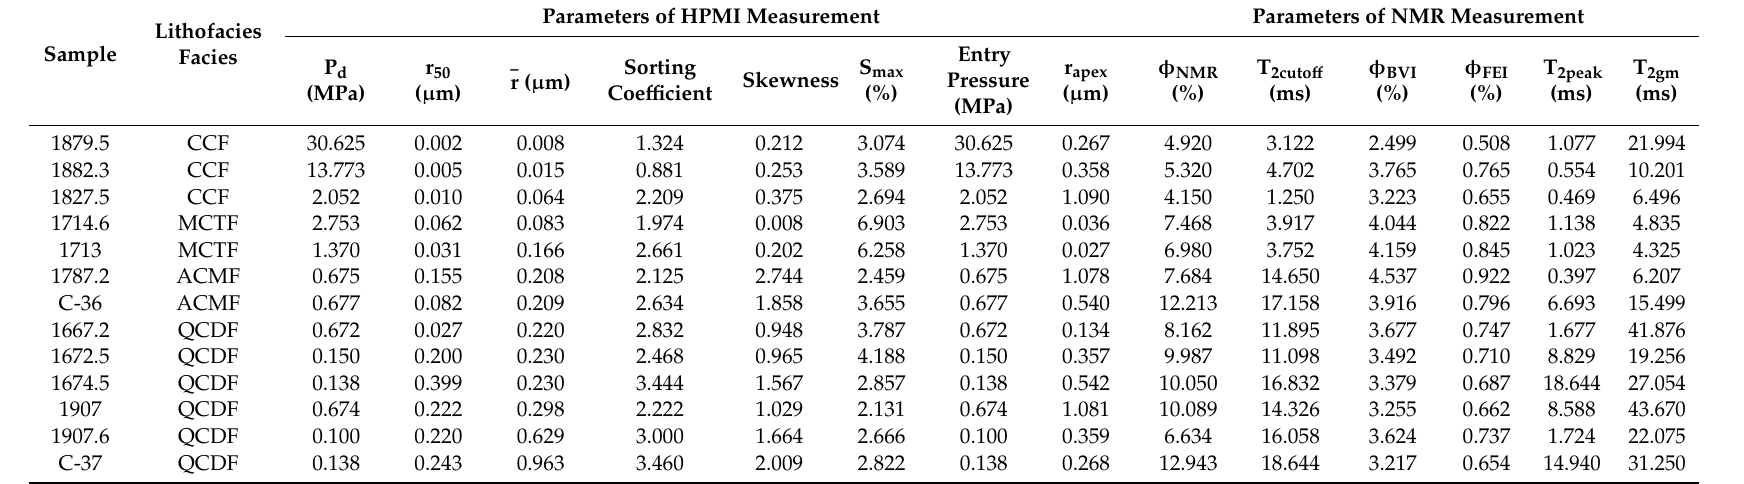
Table 3. The parameters of pore structure in J 1 b tight sandstones from NMR and